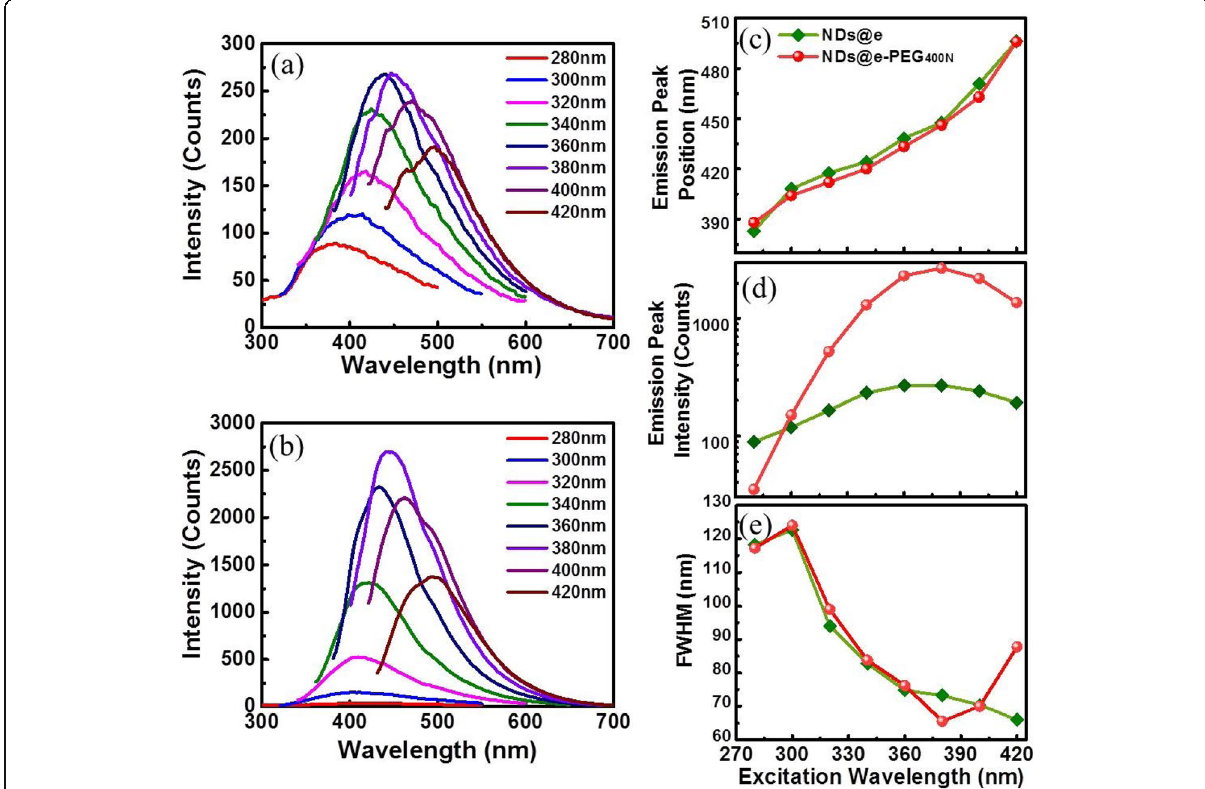
Fig. 5 Luminescence spectra of un-passivated ( a ) and passivated ( b ) NDs excited at 280 – 420 nm. The change in luminescence peak wavelengths ( c ), luminescence peak intensity ( d ), and FWHM ( e ) are various with the excitation